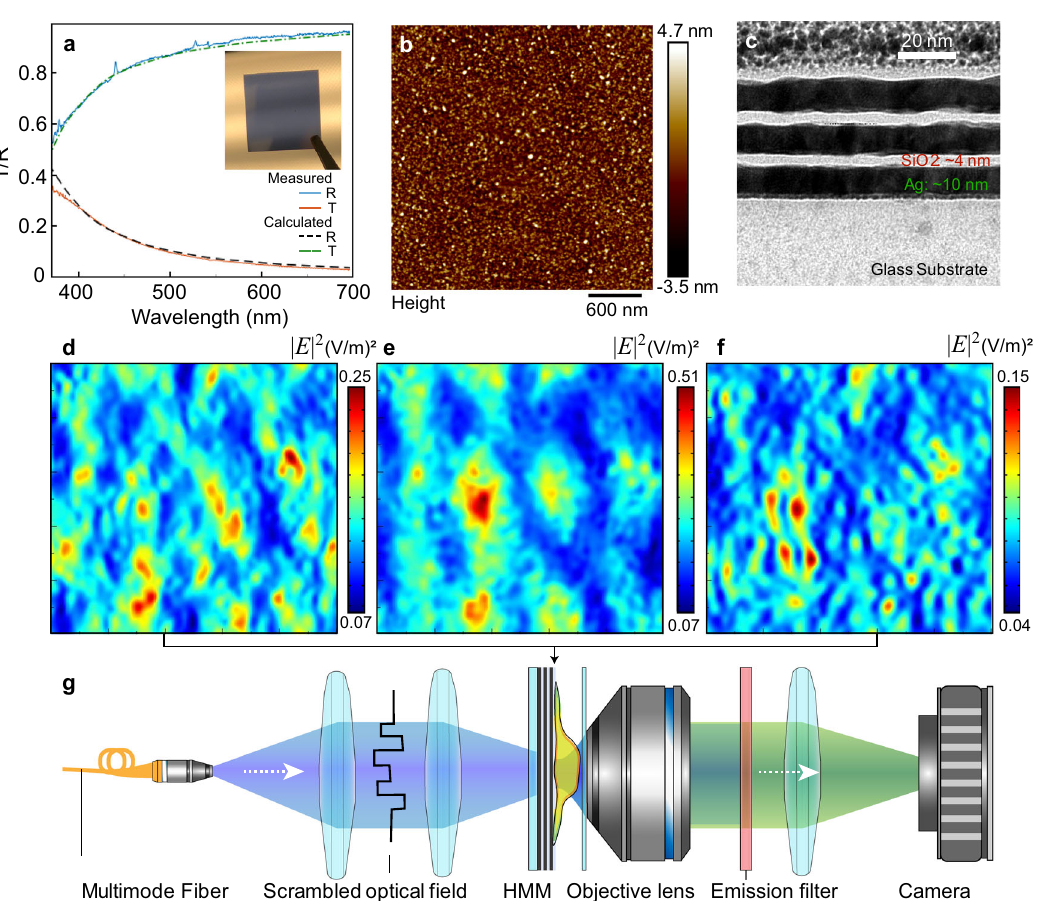
Fig. 2 Multilayer HMM characterization and simulation. a Transmittance (T) and re fl ectance (R) at normal incidence of the Ag-SiO 2 multilayer HMM. Inset image: a photo of the HMM-coated cover glass. Calculation is done based on transfer matrix method for 3 pairs of {10 nm Ag and 4 nm SiO 2 } on glass. b AFM image of the top surface. Scan area: 3 μ m × 3 μ m (512 pixels × 512 pixels). c TEM cross-section shows 3 pairs of 10 nm Ag and 4 nm SiO 2 on top of a glass substrate with Cr adhesion layer. d – f Simulated light intensities (| E | 2 ) on x - y plane at 10 nm on top of the HMM. The total simulated size of illumination pattern is 1 μ m × 1 μ m. d θ = 0°, λ = 500 nm; e, θ = 45°, λ = 500 nm; f θ = 0°, λ = 600 nm. θ is the incident angle; λ is the operating wavelength. g Schematics of the experimental set-up of (Fig. 4a – i), indicating the robustness of the speckle-MAIN technology. Figure 4j – m represents a super-resolution image of a more complex object at a wide fi eld of view. The object is made by a dense drop-casting of quantum dots emitting at 605 nm. The quantum dots form certain nanostructures on top of the HMM- coated substrate. The super-resolution image reconstructed from 140 sub-frames reveals much greater details that cannot be observed by diffraction-limited images. In principle, speckle- MAIN has a fi eld of view (FOV) as wide as an epi- fl uorescent microscope, which is primarily limited by the camera sensor size. The standard 1/7 FRC resolution criteria (Supplementary Fig. 11) illustrates 65 nm Fourier space cutoff with speckle-MAIN.